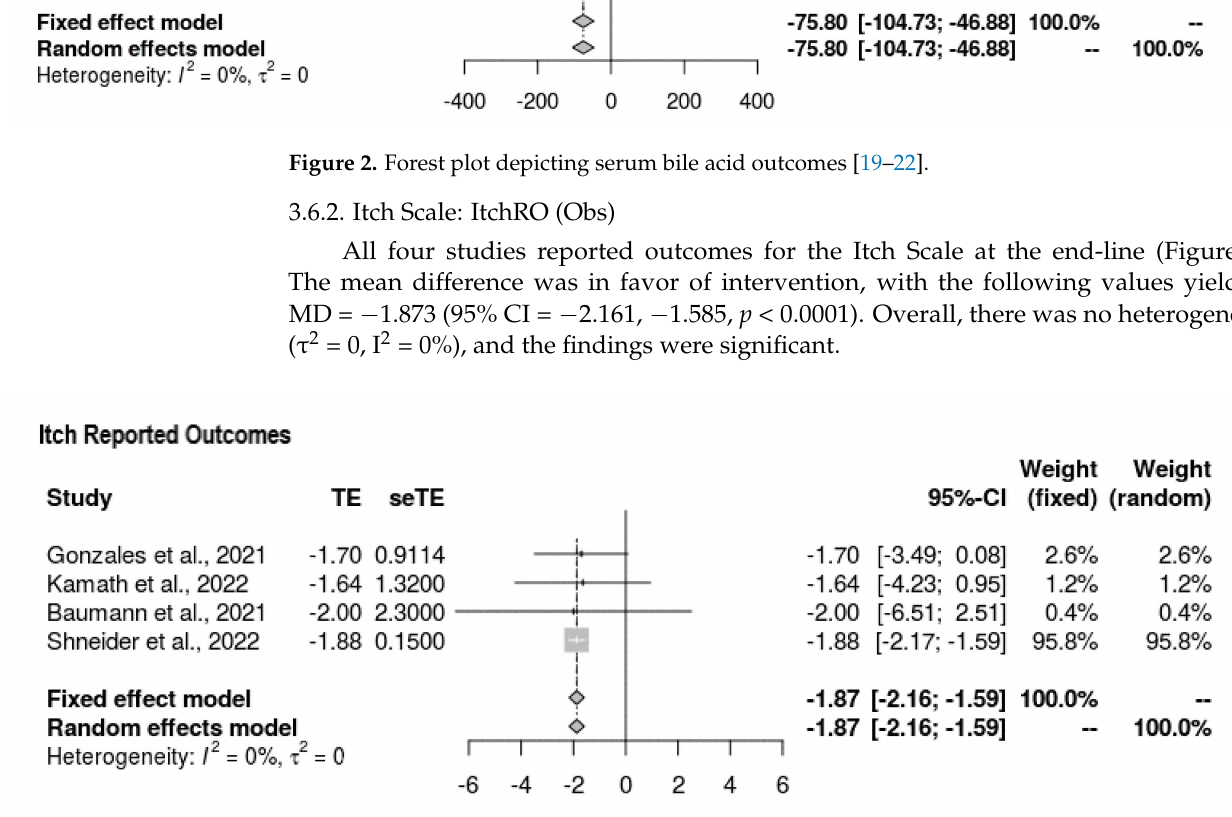
Figure 3. Forest plot depicting Itch Scale outcomes